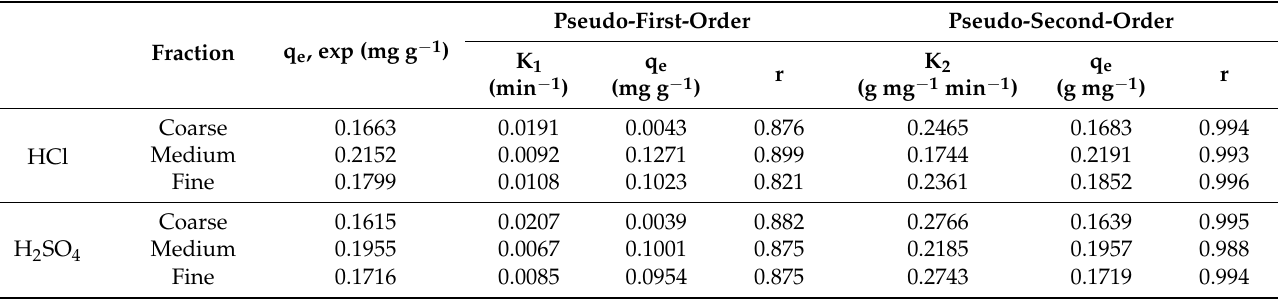
Table 5. Parameters of the kinetic models of PO 43- adsorption.